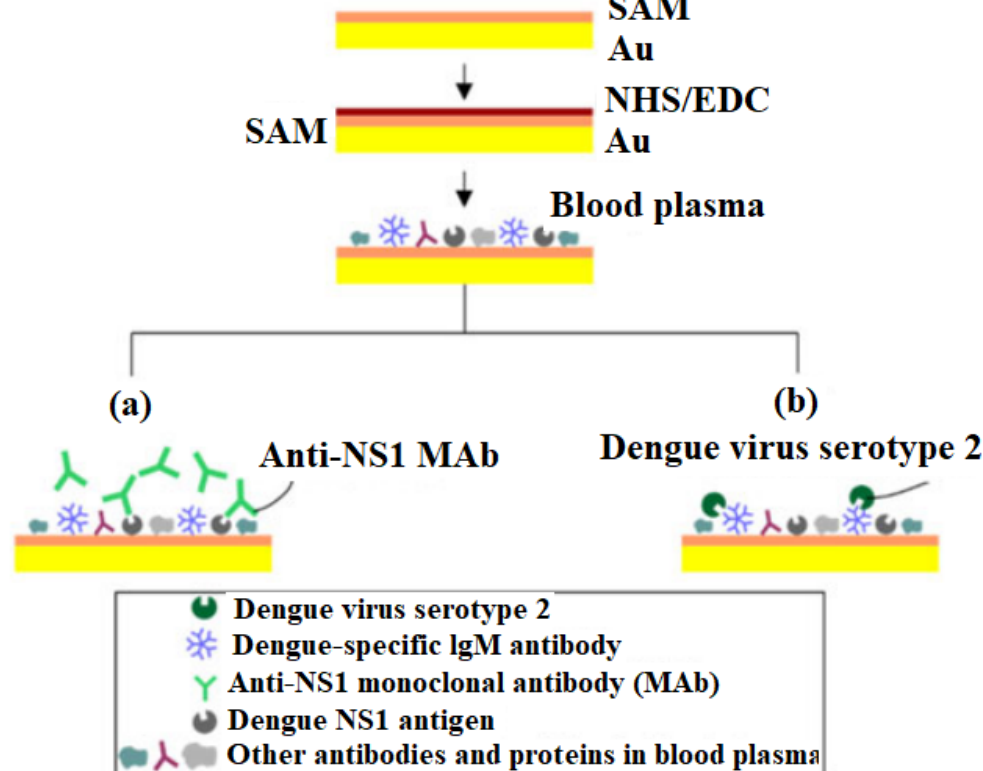
Figure 10. Schematic illustrating the functionalization of a waveguide surface for the detection of ( a ) dengue NS1 antigen and ( b ) dengue-specific IgM antibody. Copyright with permission from IEEE ref. [130].